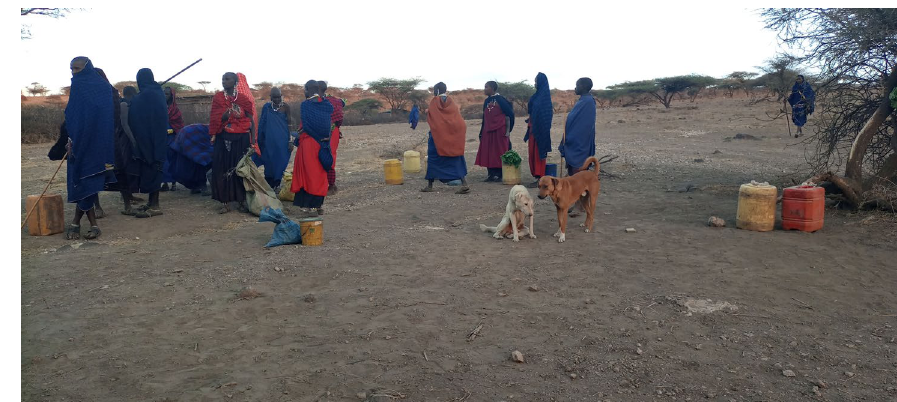
Fig. 4 Dogs kept by the respondents’ in the